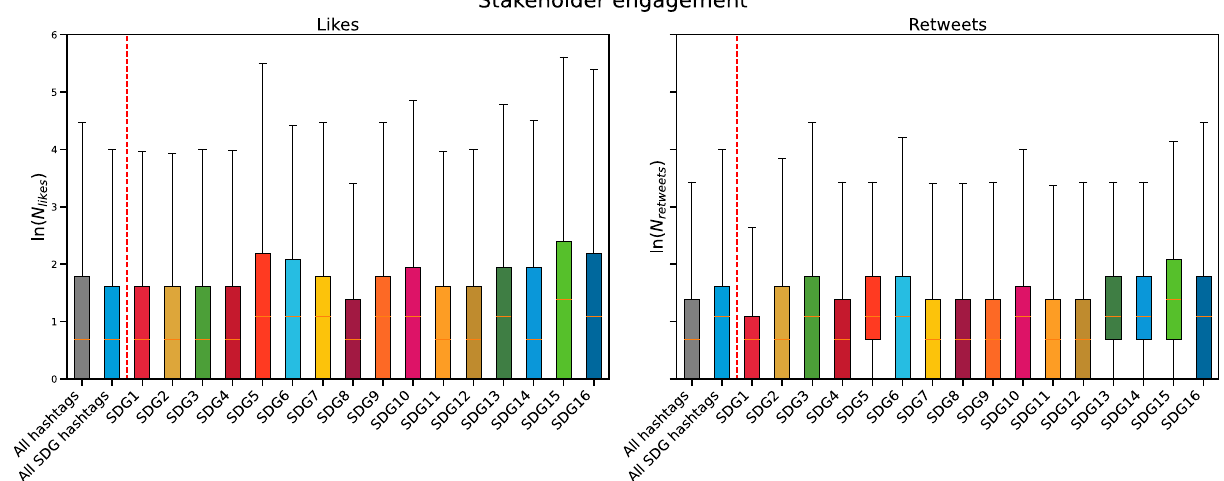
Figure 6. Stakeholder engagement on the SDGs. These boxplots compare the distribution of the number of likes and retweets for all hashtags (the gray box on the left), for each SDG (all the boxes beyond the red line; boxes are colored using the official indication from UN, https:// www. un. org/ susta inabl edeve lopme nt/ wp- conte nt/ uploa ds/ 2019/ 01/ SDG_ Guide lines_ AUG_ 2019_ Final. pdf ), and for all the SDGs hashtags (the sky blue box on the left). The boxplots show the distribution of the logarithm of the number of likes and retweets. We used the logarithms because the distributions are heavy-tailed. In this sense, boxplots may not be the perfect tool for capturing the distribution properties but can effectively deliver the message about the rough differences among the various